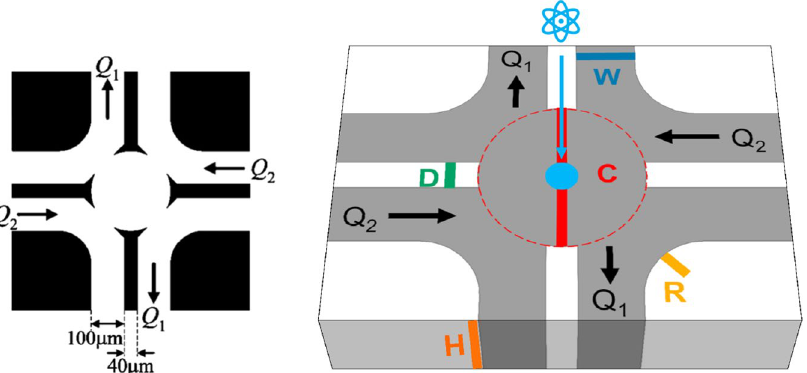
Figure 1. (left) Original microfluidic four-roll mill design reproduced from Lee et al . 21 . (right) Schematic 2D representation of the parameterized FFoRM geometry. Geometric parameters that were varied in the device design are indicated with colored letters. The 1 mm diameter neutron beam cross section is indicated as a light blue circle in the center of the device. The included values of these geometric parameters are the final choice of geometry with W = 2 mm, D = 1 mm, R = 1 mm, C = 5 mm, and H = 3 mm. Channels with controlled flow rates Q 1 and Q 2 are indicated with black arrows.